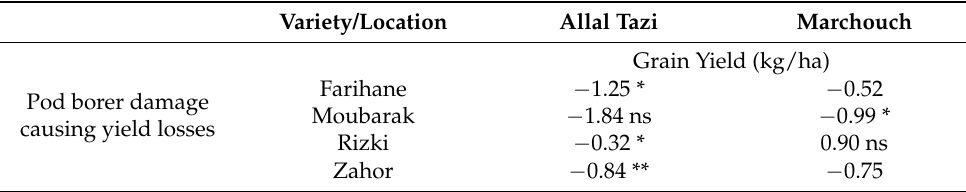
Table 2. Simple correlations between chickpea pod borer damage and grain